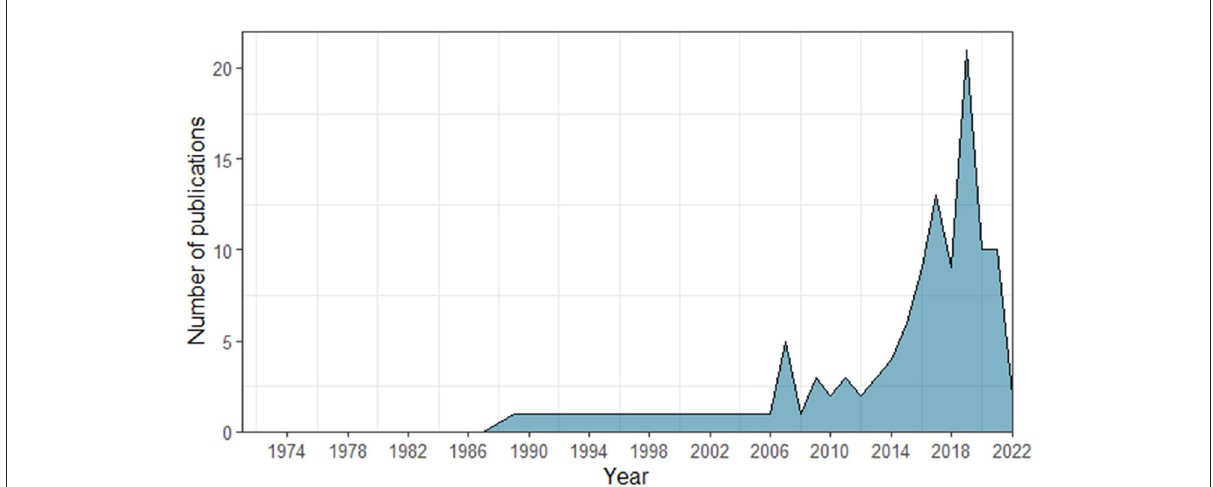
FIGURE2 Number of non-human animal studies indexed in the Scopus and Web of Science databases, including the term “turn-taking” across years (1971–2022).